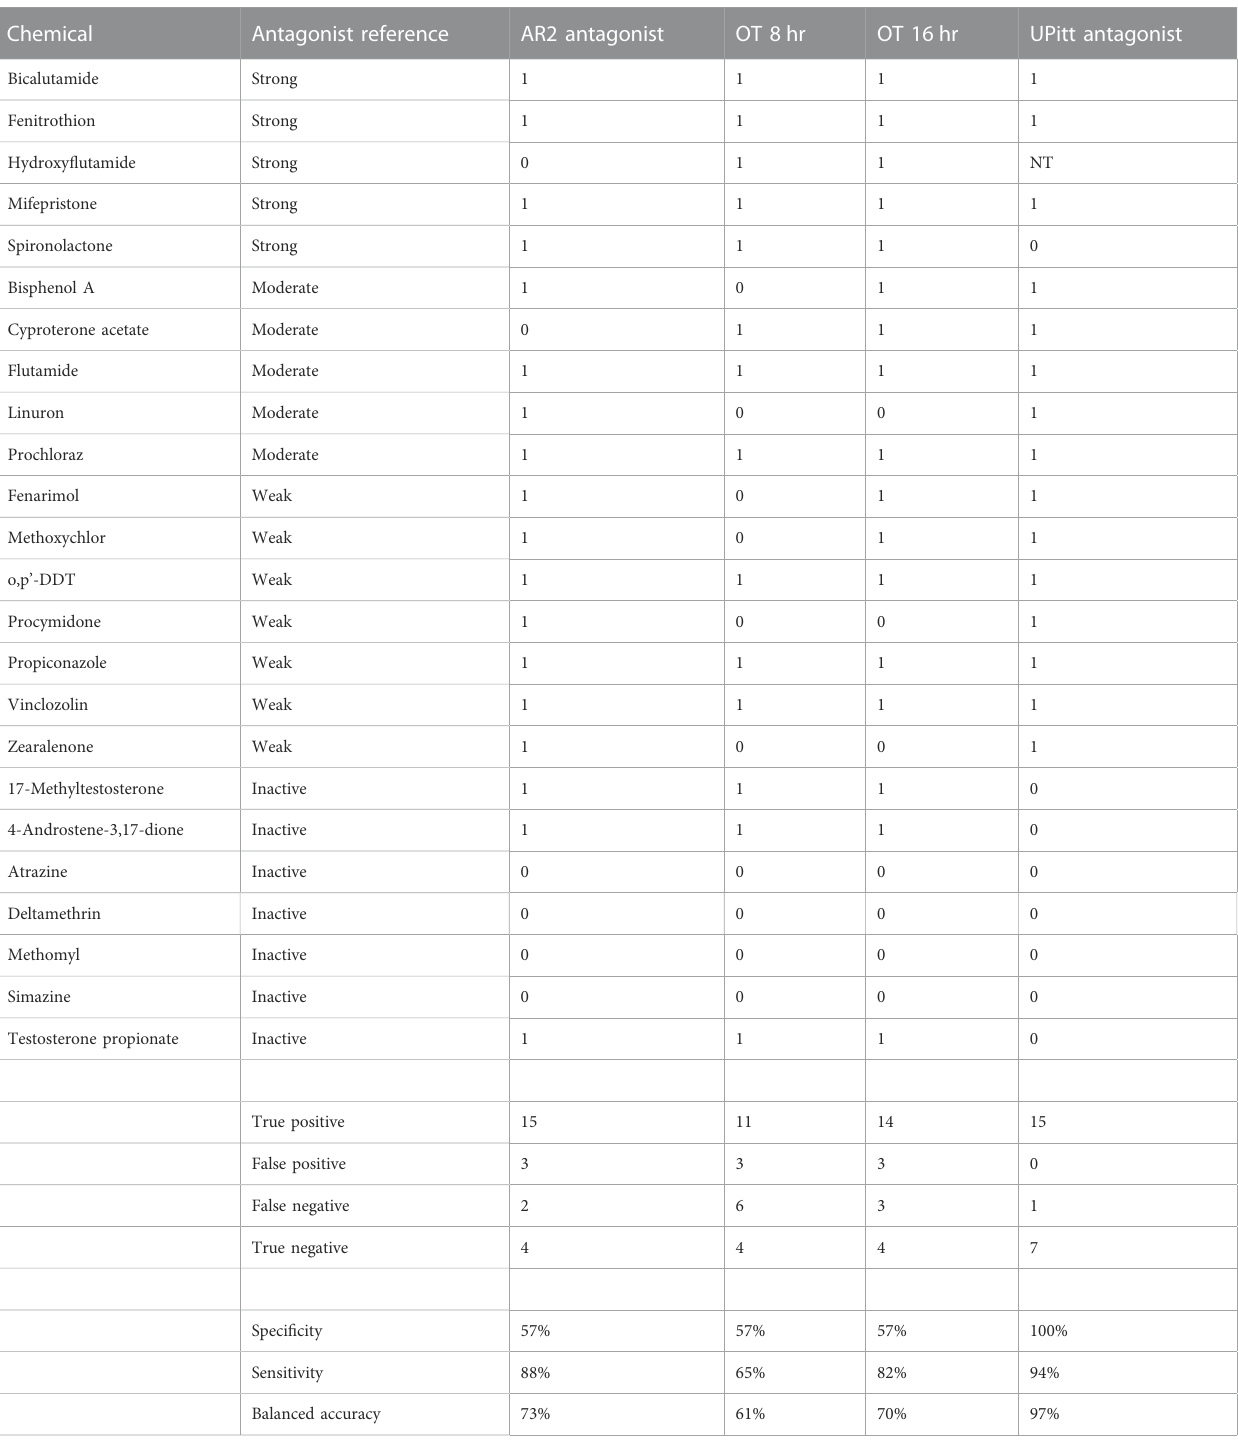
TABLE 3 Assay Comparison using Reference